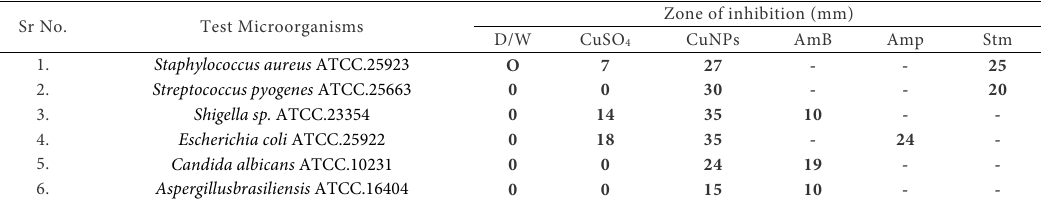
Table 5. Antimicrobial activity of CuNPs